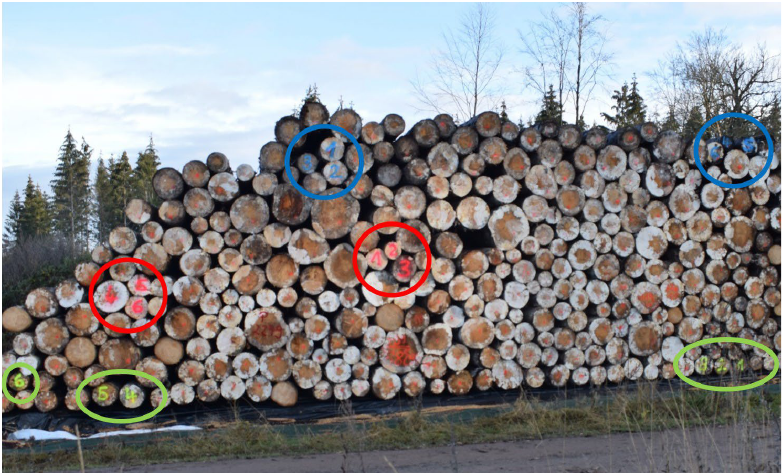
Figure 3. Foil-packed pile no. 5 after terminating the storage and removal of the foil. Logs for quality assessment are marked blue (top), red (middle) and green (bottom). The mean diameter of the sections was determined and both end-grain surfaces were photographed. The quality of the wood was evaluated using several cross-sections. For this purpose, a slice about 3 cm thick was cut off on both end-grain sides of the section. Further cuts were made after 20, 125, 250 and 375 cm. The log quality was assigned to quality classes B/C or D according to RVR (Framework agreement for the raw wood